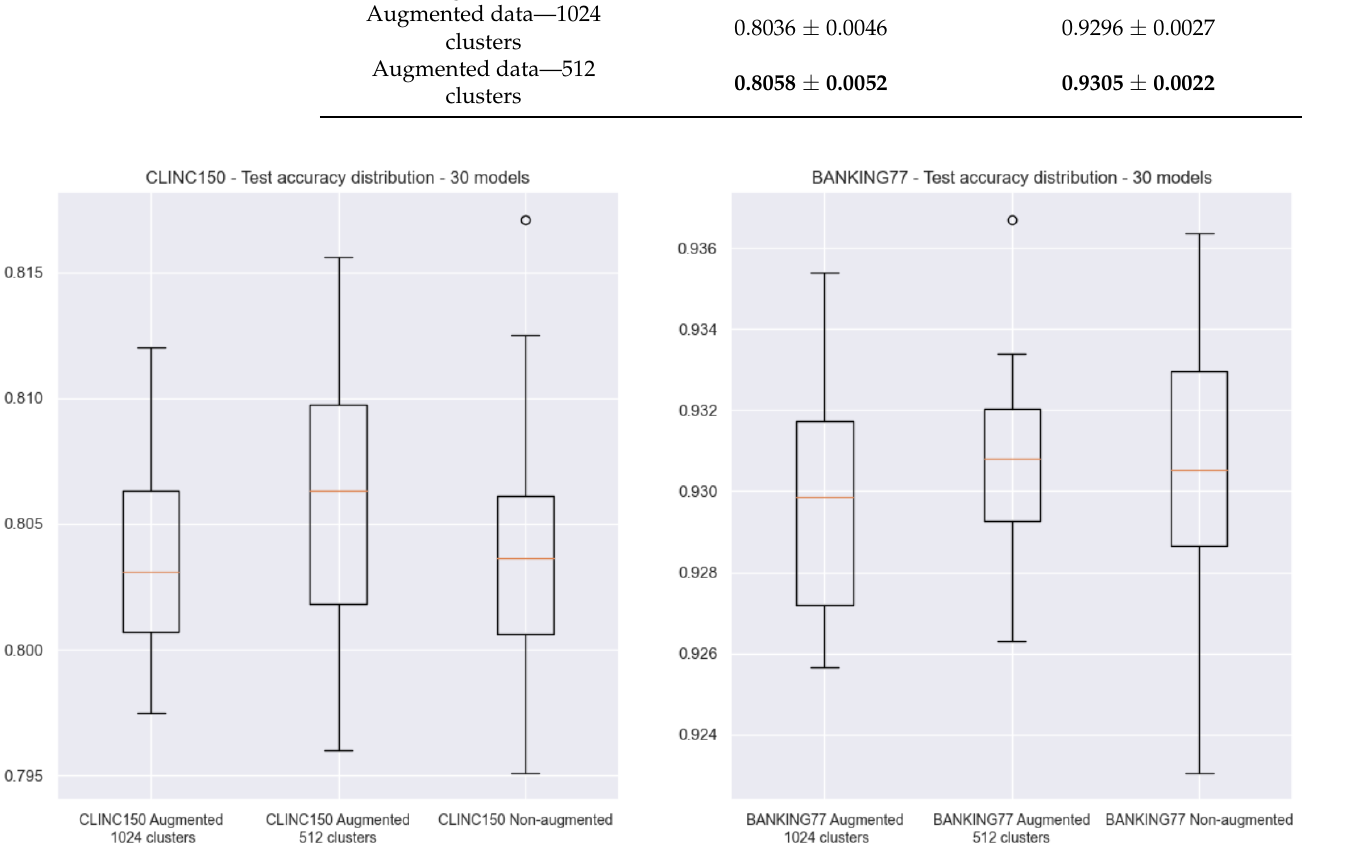
Figure 2. Box and whisker plots obtained when training an ensemble of 30 models for each combi- nation of dataset and augmentation method. Augmented training sets do not improve the mean accuracy on the test set, but reduce variance across models. Whiskers extend from the lower to the upper quartile of the